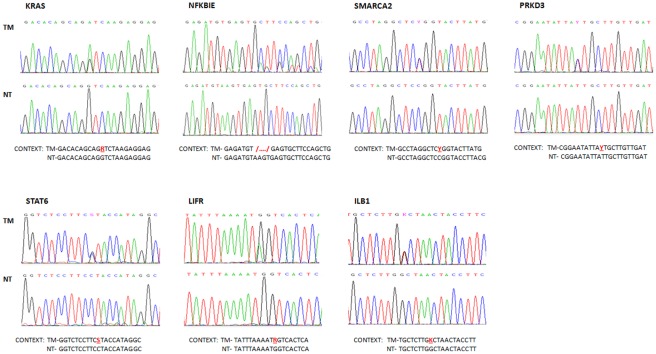
Mutation validation.Capillary sequencing chromatograms confirming the seven putative variants. KRAS, SMARCA2, PRKD3, STAT6, LIFR and ILB1 showed one point mutation each, depicted as two peaks in the tumoral DNA chromatogram. For NFKBIE, the 4-bp deletion was also confirmed. NT = non-tumoral, TM = tumoral. R = A or G; Y = C or T; S = C or G; K = T or G; /…./ = 4-bp deletion.